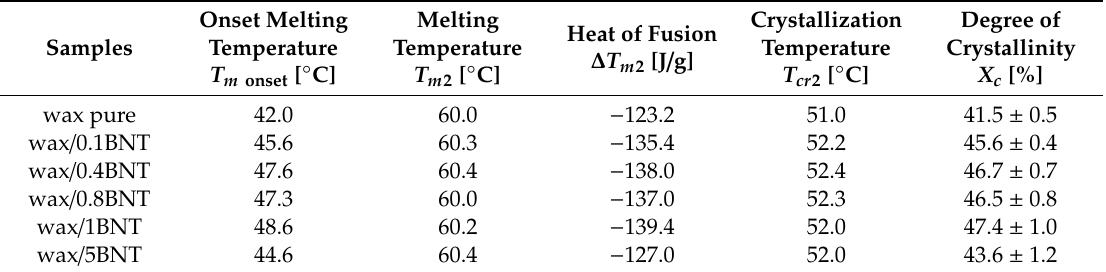
Table 6. DSC data of pure PE-wax and its blends with various content of the bentonite.